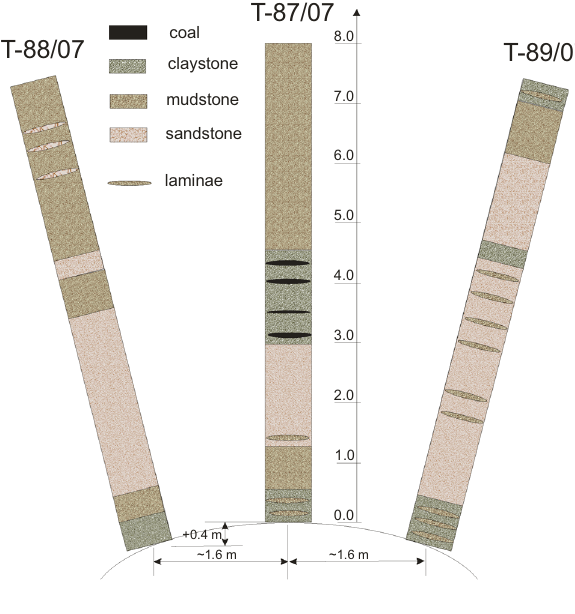
Fig. 3 Lithology of the boreholes drilled in Roadway B-7